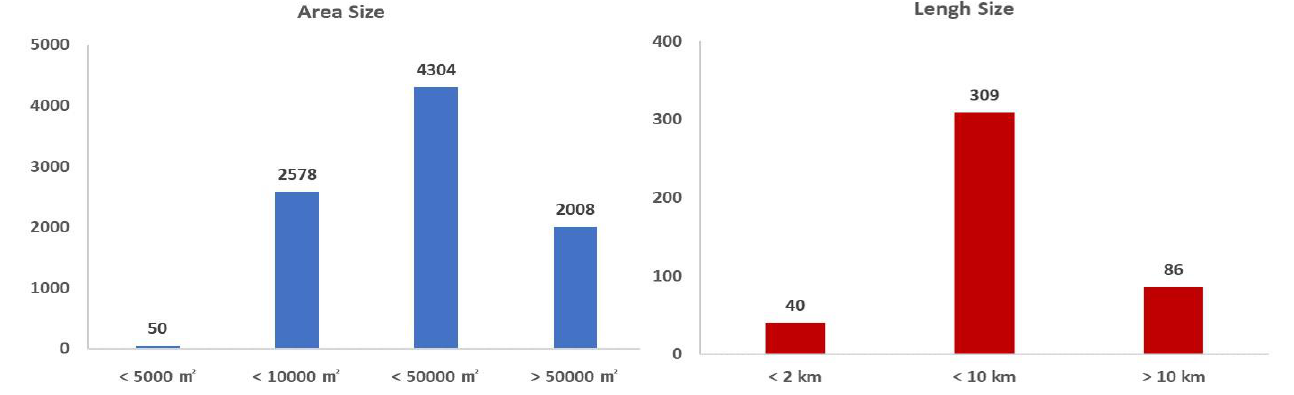
Figure 5. DIA results by area and length size (2015 – 2017).